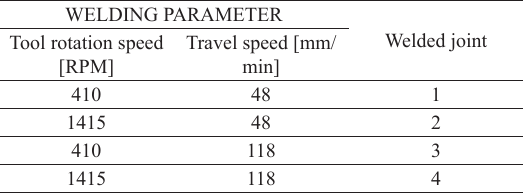
Table 2. Welding parameter values used. WELDING PARAMETER